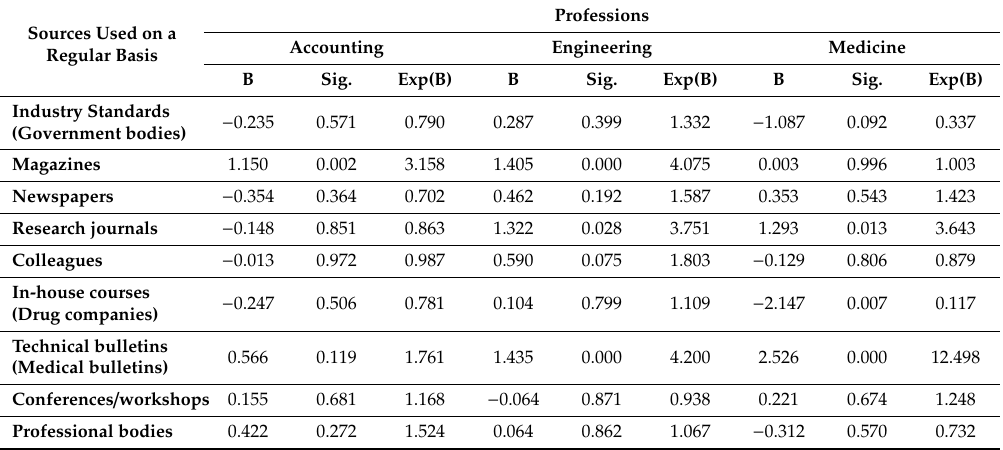
Table 6. Sources used on a regular basis: Comparison of the three professions. Sources Used on a Regular